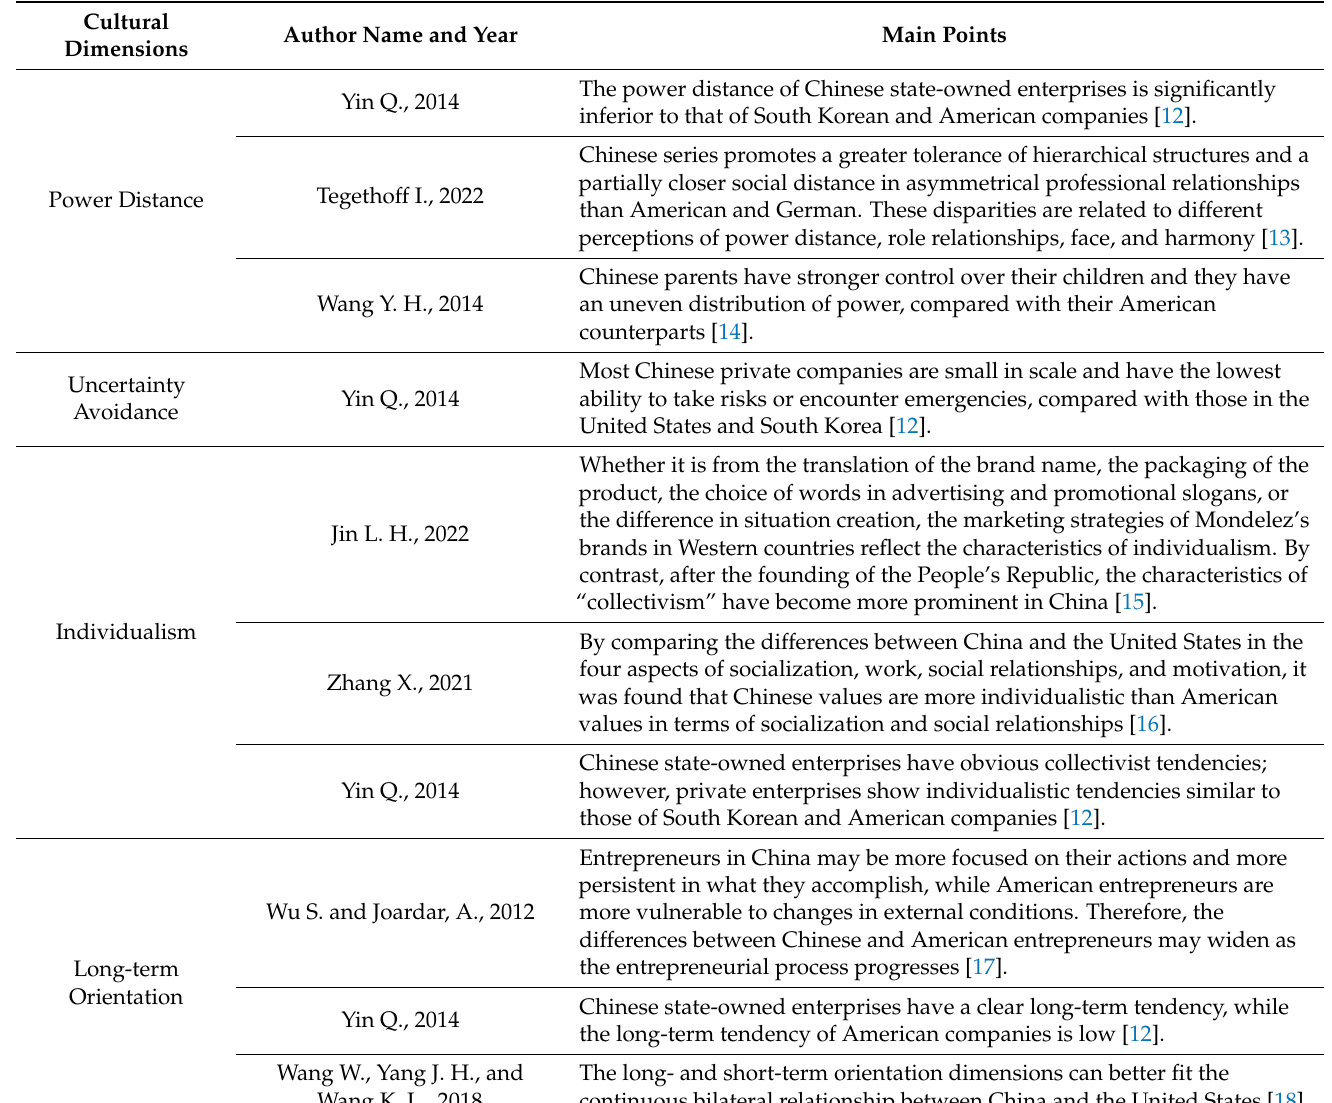
Table 1. A review of studies on cultural dimensions in China and the United